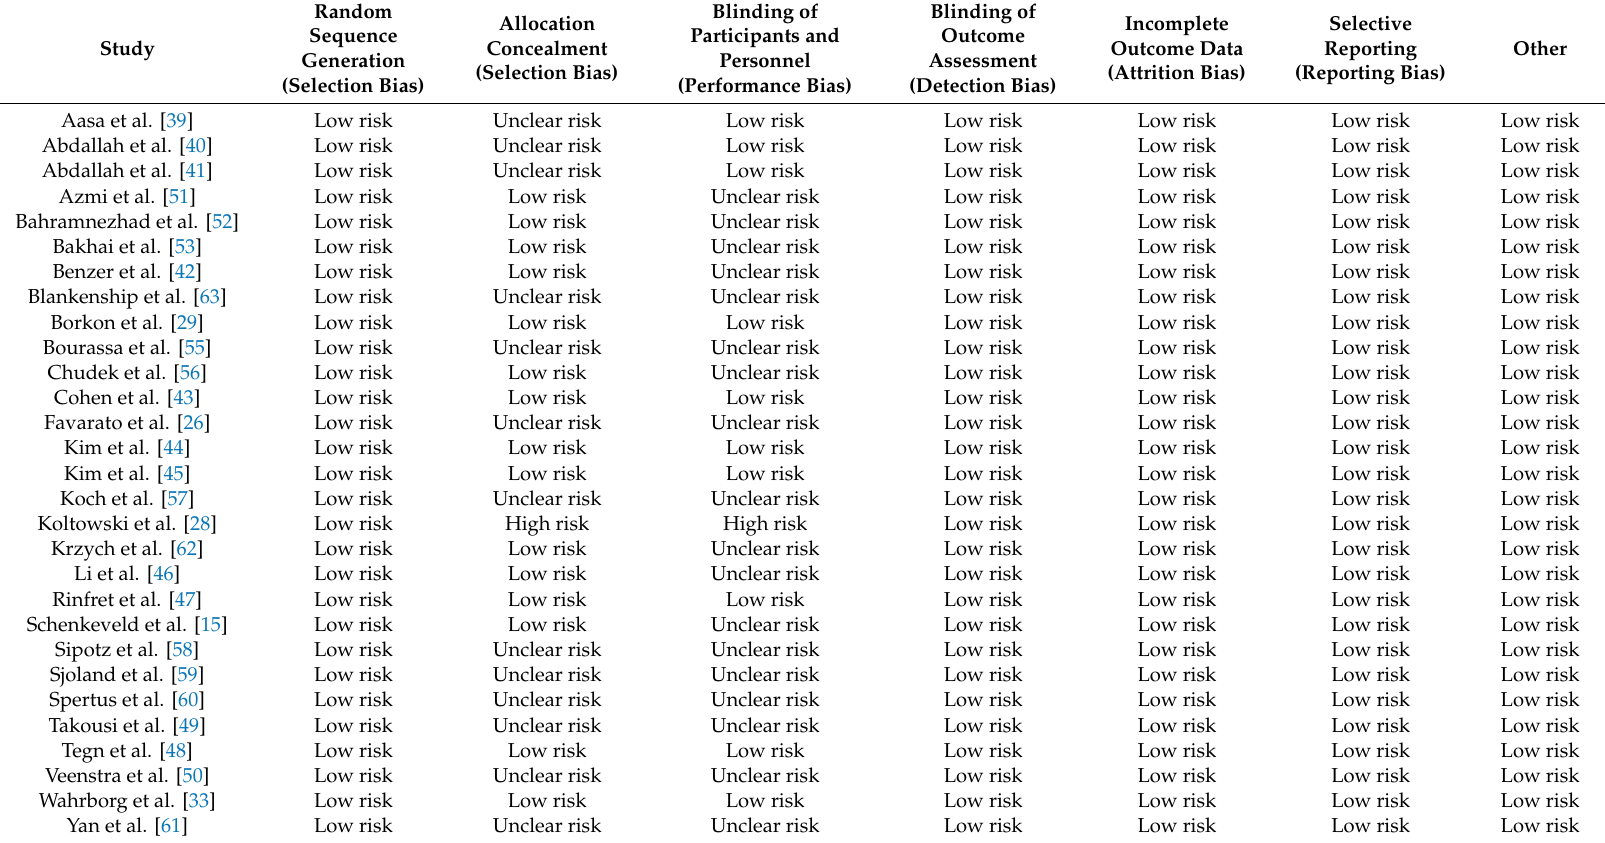
Table 3. Risk of Bias Assessment within the studies ( n =